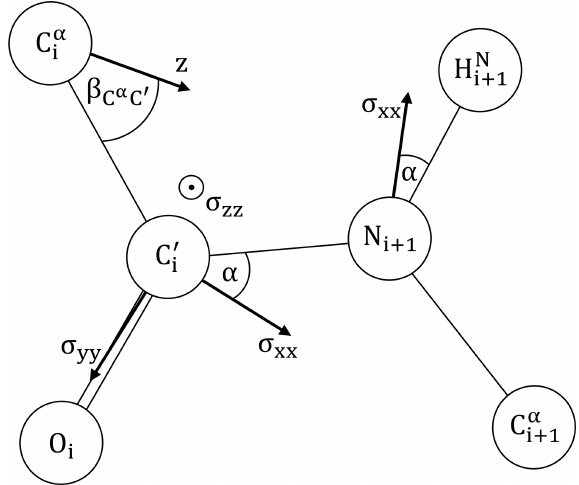
Figure 2. The peptide plane as defined by Corey et al. (1953): C α − C (cid:48) = 1 . 53Å, C (cid:48) − O = 1 . 24Å, C (cid:48) − N = 1 . 32Å, N − C α = 1 . 47Å. C α − C (cid:48) − O = 121 ◦ , C α − C (cid:48) − N = 114 ◦ , O − C (cid:48) − N = 125 ◦ , C (cid:48) − N − H = 123 ◦ , C (cid:48) − N − C α = 123 ◦ and H − N − C α = 114 ◦ . N − H = 1 . 04Å is taken from Ottiger and Bax (1998). The 15 N and 13 C (cid:48) CSA principal components are adapted from Bodenhausen and coworkers (Cisnetti et al., 2004; Loth et al., 2005). 15 N: (cid:49) N ≈ σ xx − σ yy ≈ σ xx − σ zz = 170ppm, α = 20 ◦ . 13 C (cid:48) : σ xx = 249 . 4ppm, σ zz = 87 . 9ppm, α = 37 ◦ . σ yy = 191 . 1ppm is obtained from the average chemical shift of ubiquitin (BMRB 17769) (Cornilescu et al., 1998), following the suggested calibration (Cis- netti et al., 2004). The main axis z of the diffusion anisotropy tensor is assumed to lie in the peptide plane. Its orientation is encoded by β C α C (cid:48)